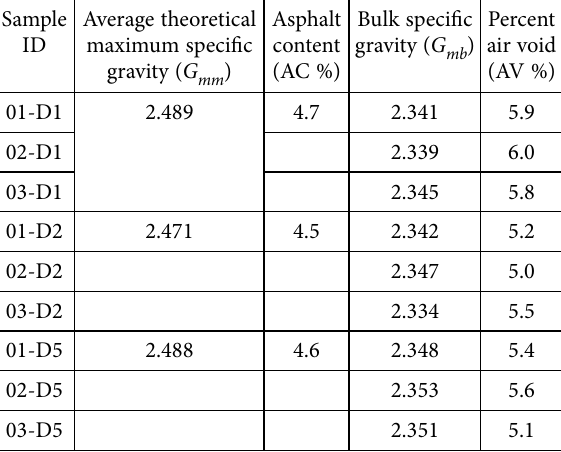
Table 4. Summary of Maximum Specific Gravity, Asphalt Content, Bulk Specific Gravity and Percent Air Void for the collected HMA samples Sample Average theoretical ID maximum specific ) gravity ( G mm